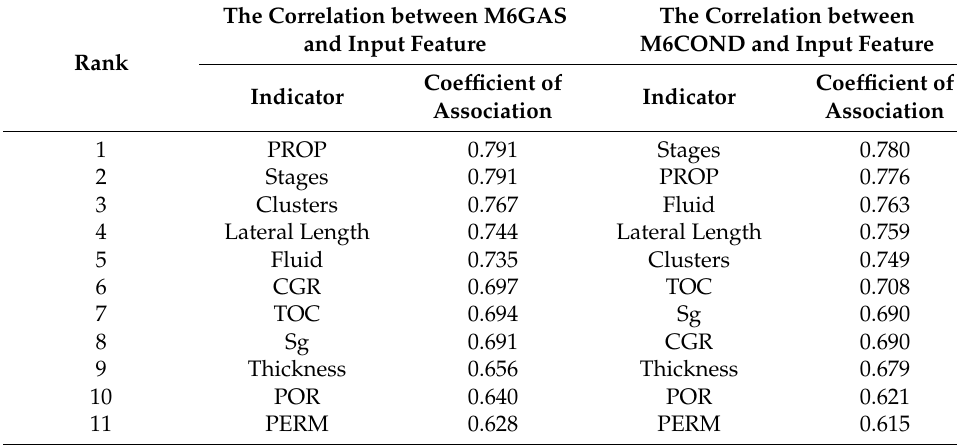
Table 3. The correlation between responses and